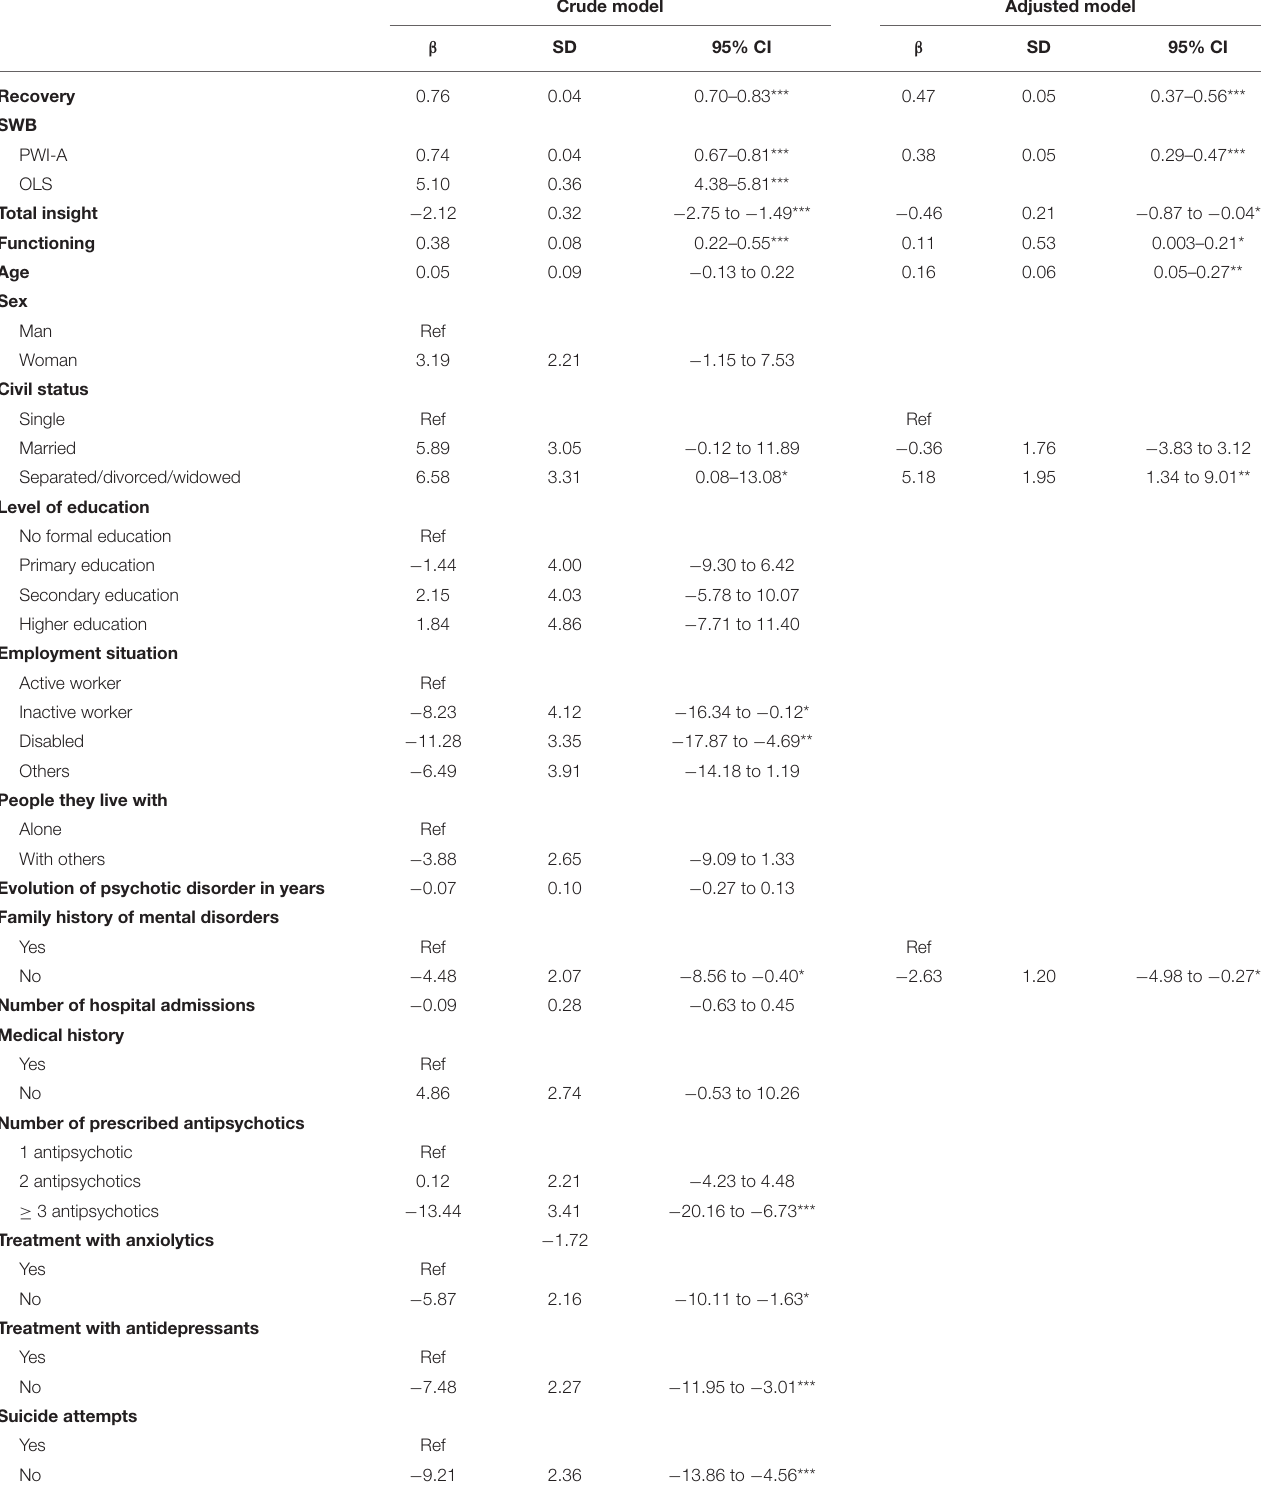
TABLE 4 | Multivariate regression analysis of factors associated with